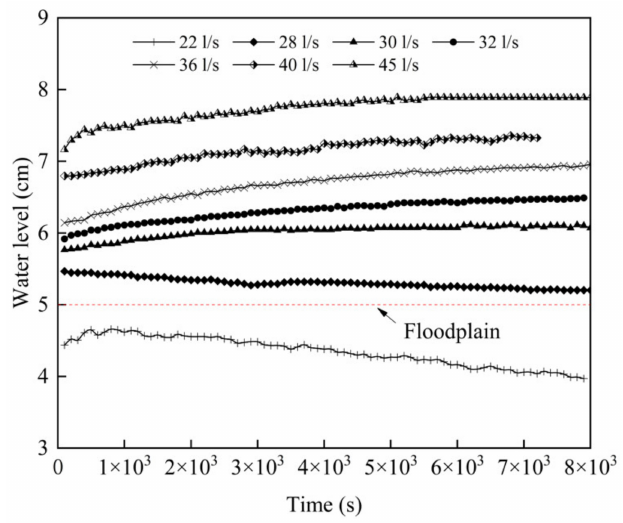
Figure 6. Temporal evolution of water level at x = 5